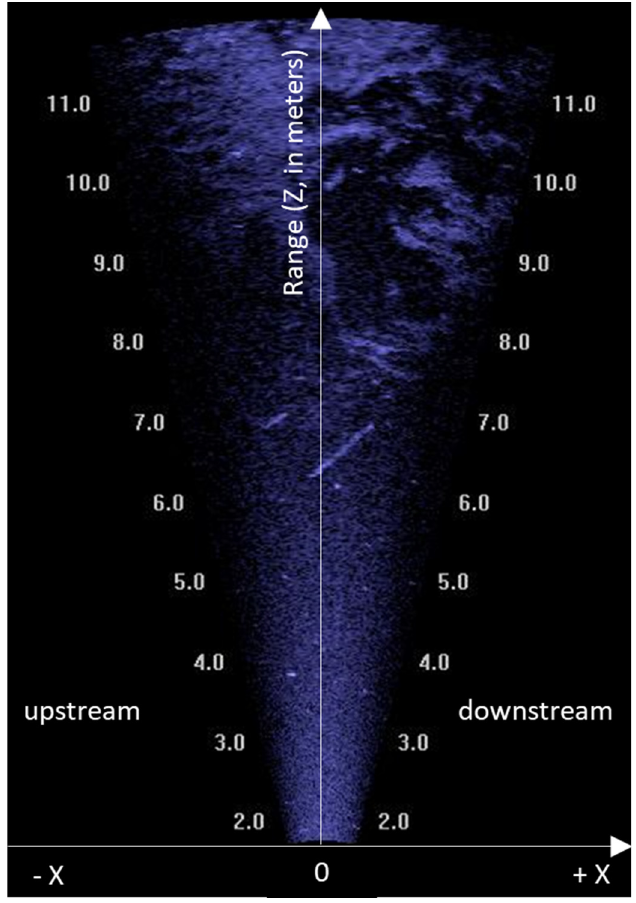
Fig. 2. Exported frame recorded by the DIDSON on the Sélune River monitoring site. The camera been set on the right riverbank; the river fl ow goes from left to